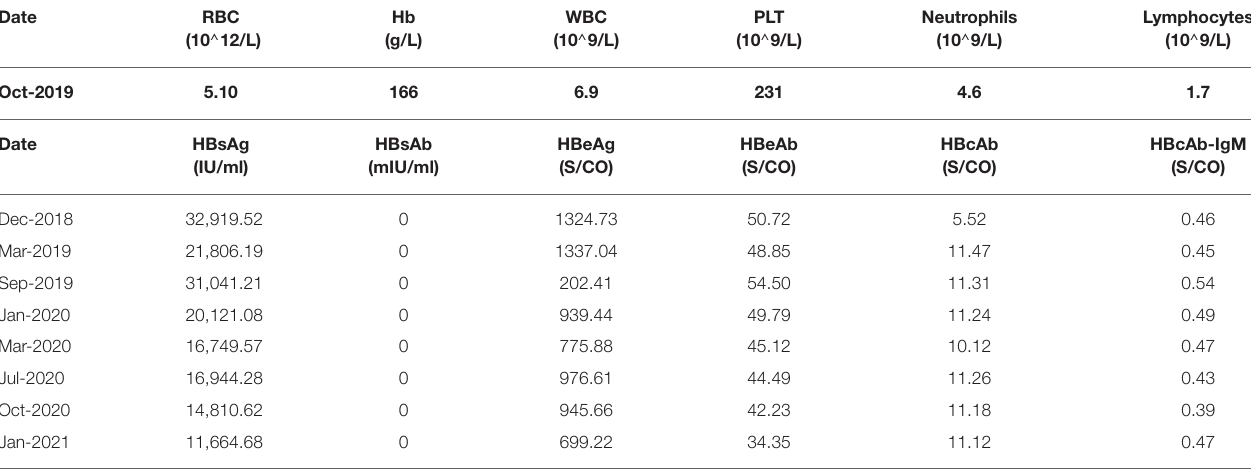
TABLE 1 | Routine blood parameters and the kinetics of HBV-specific antigens and antibodies of patient 1#.